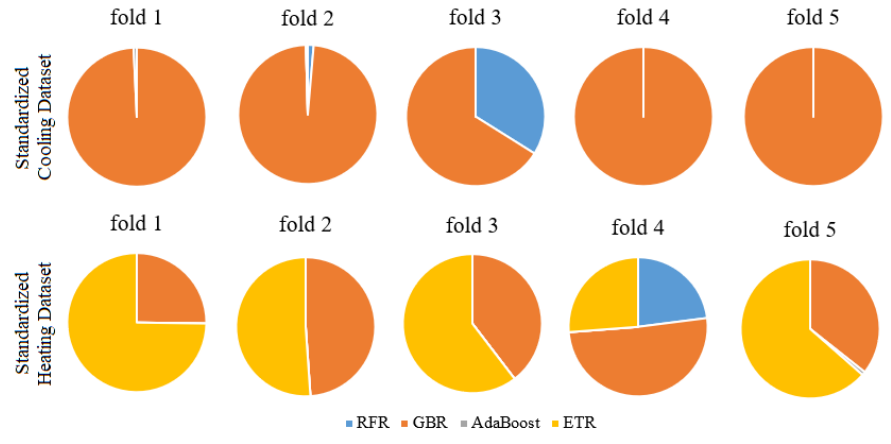
Figure 14. PTA Ensemble Weight Summary When Standardization is Applied.